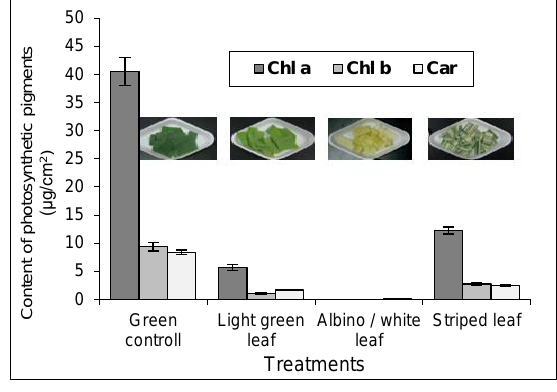
Figure 5. Photosynthetic pigments content of giant reed leaf variants Source: photos by Gabriella Antal. It was significant differences (p<0.05) between types (Tukey test).